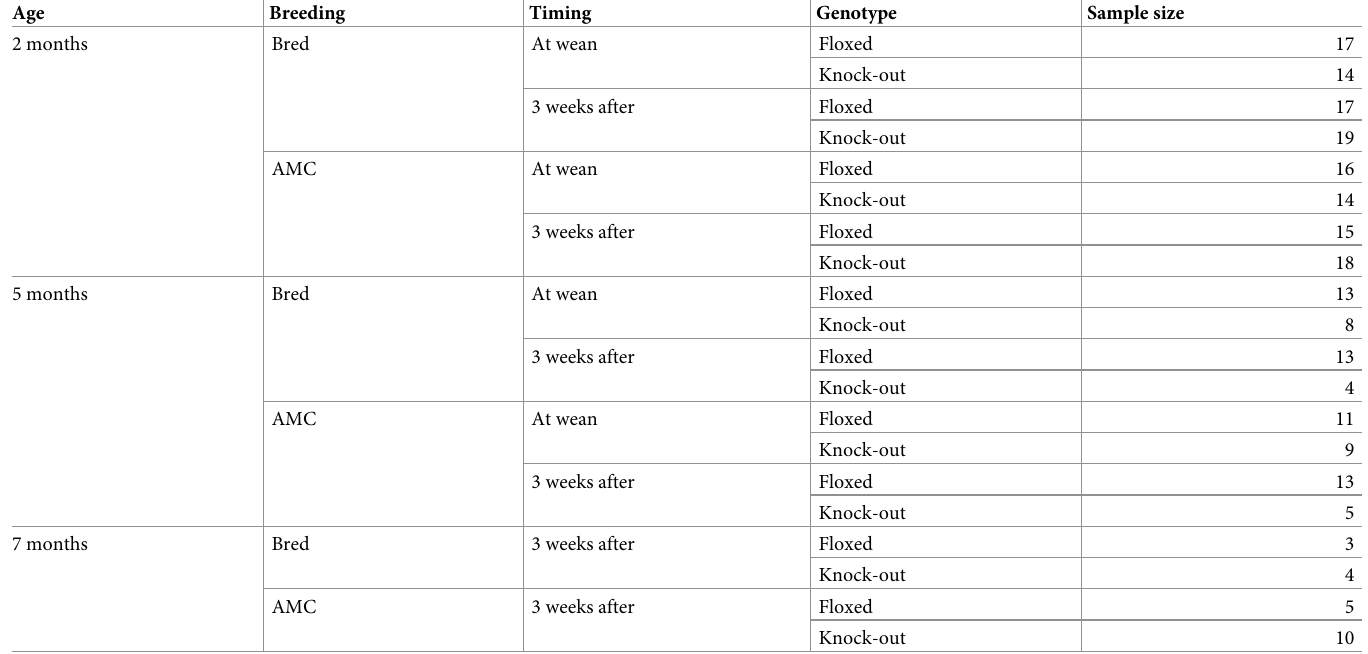
Table 2. Sample sizes in analyses of the effects of age and Pappa2 deletion on the recovery of the skeleton after